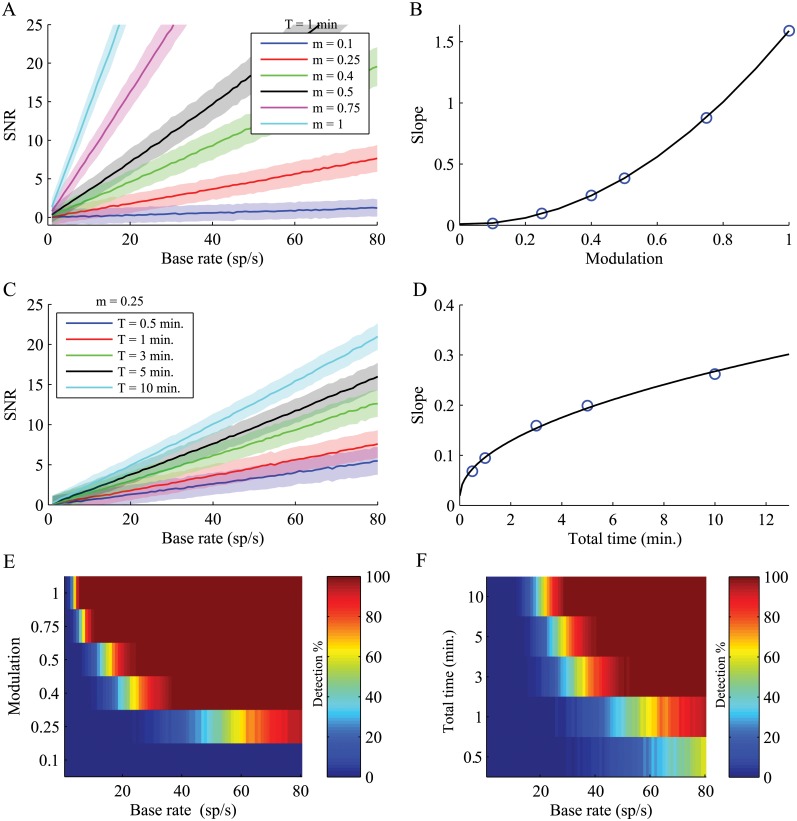
Factors determining the spectral peak magnitude.(A) Effect of the rate modulation (m) in different base firing rates (r
0) over a fixed recording period (T = 1 minute). The solid lines indicate the mean SNRs; the shaded areas indicate ±1 STD of the SNR. (B) A squared fitting function for the SNR slopes (R2 = 1, p <0.001). (C) Effect of the recording period duration (T) in different firing rates during a fixed firing modulation (m = 0.25). (D) A square root fitting function for the SNR slopes (R2 = 0.99). (E-F) The detection of a significant peak (SNR>5) is affected by the rates for different (E) rate modulations and (F) recording durations.